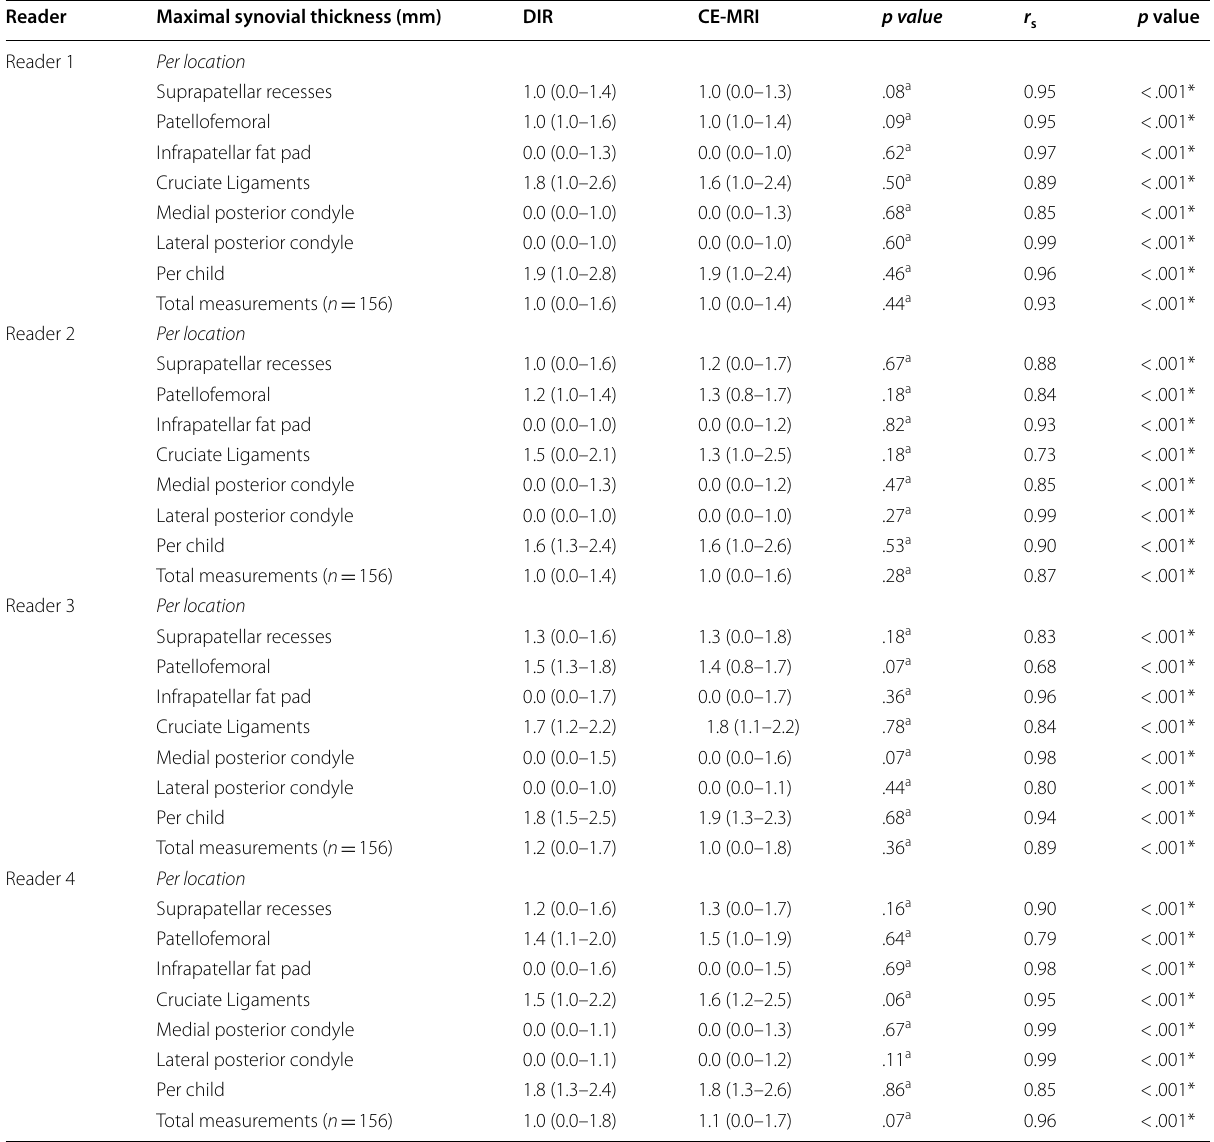
Data are displayed as median (interquartile range). Data are based on 26 measurements, unless otherwise stated r s , Spearman’s rank-order correlation; DIR, double inversion recovery; CE,